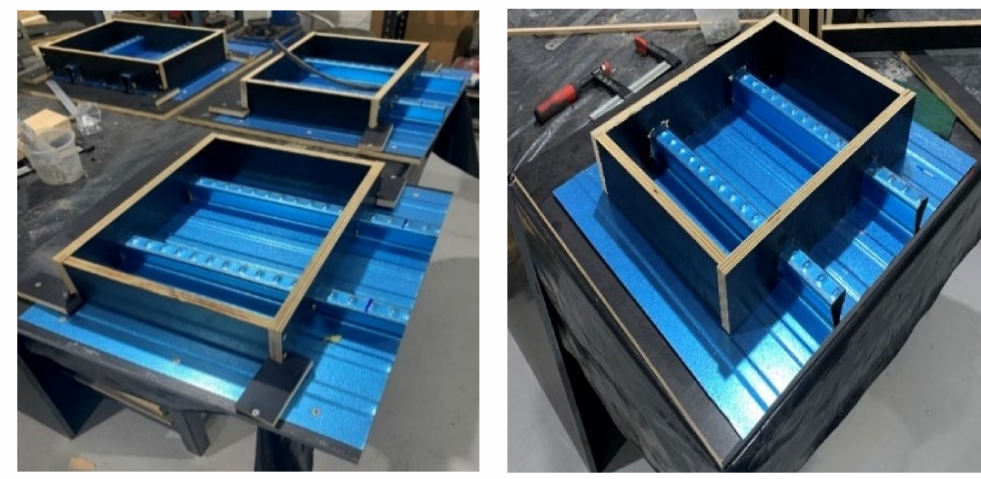
Figure 8. Specimen’s